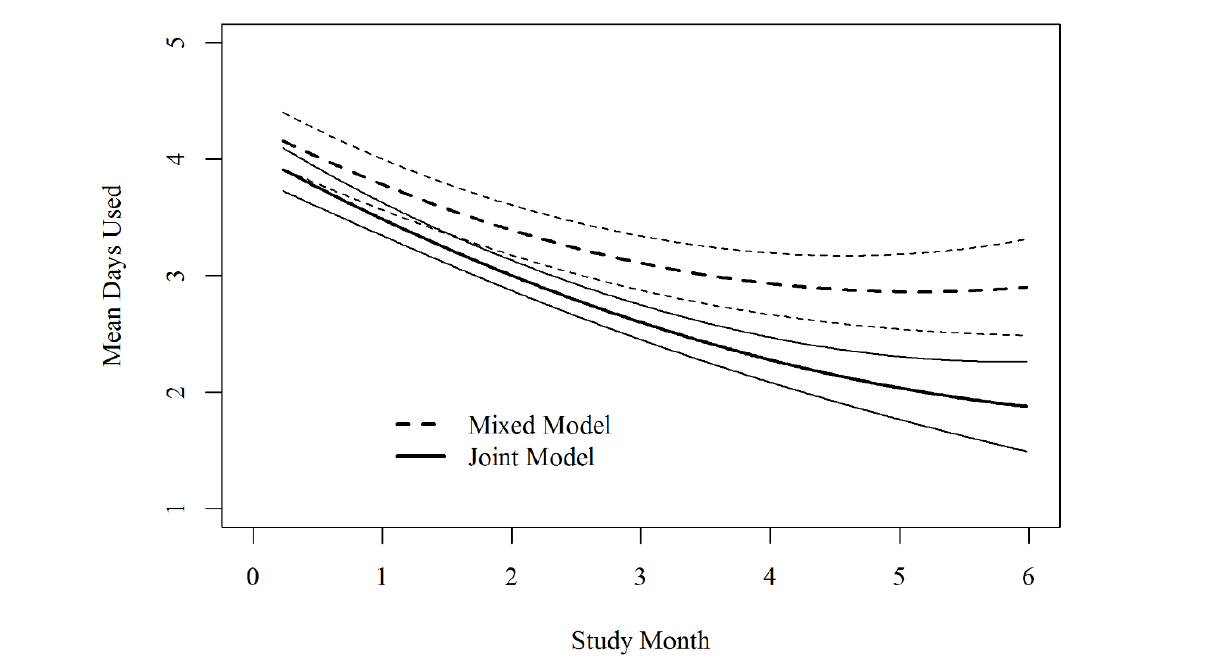
Figure 3. Model-based estimated mean engagement with mHealth intervention (intervention use) over the course of the study. Estimates (and 95% confidence intervals) from the joint model of engagement and time-to-drop-out and from the naïve mixed effects model not accounting for drop-out are displayed.